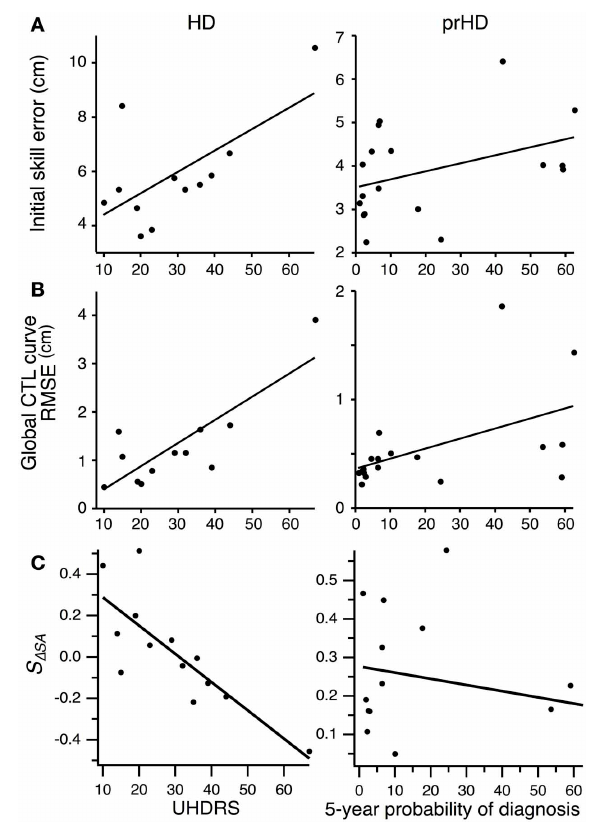
FIGURE 8 | Correlation between motor performance and disease severity for HD subjects, and between motor performance and proximity to symptom onset for prHD subjects. Each point represents individual subject averages. Lines indicate linear regressions. (A) Relationship between initial skill error and UHDRS for HD subjects (left), and between initial skill error and 5-year probability of diagnosis for prHD subjects (right). (B) Relationship between the RMSE calculated with respect to the global exponential CTL curve and UHDRS for HD subjects (left), and between RMSE and 5-year probability of diagnosis for prHD subjects (right). (C) Relationship between speed-accuracy-change slope ( S (cid:2) SA ) and UHDRS score for HD subjects (left), and between this slope and 5-year probability of diagnosis for prHD subjects